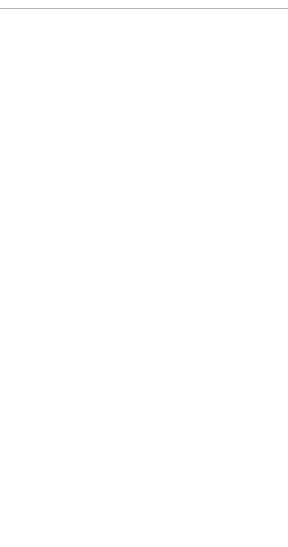
TABLE 3 | Tentative correlation of historical time events and paleoenvironment during the last 2,200 years (Wikipedia, 2021) in the Z ă ton Lake area, as inferred from fossil oribatids and sediment data. Blue = colder periods; red = warmer periods.